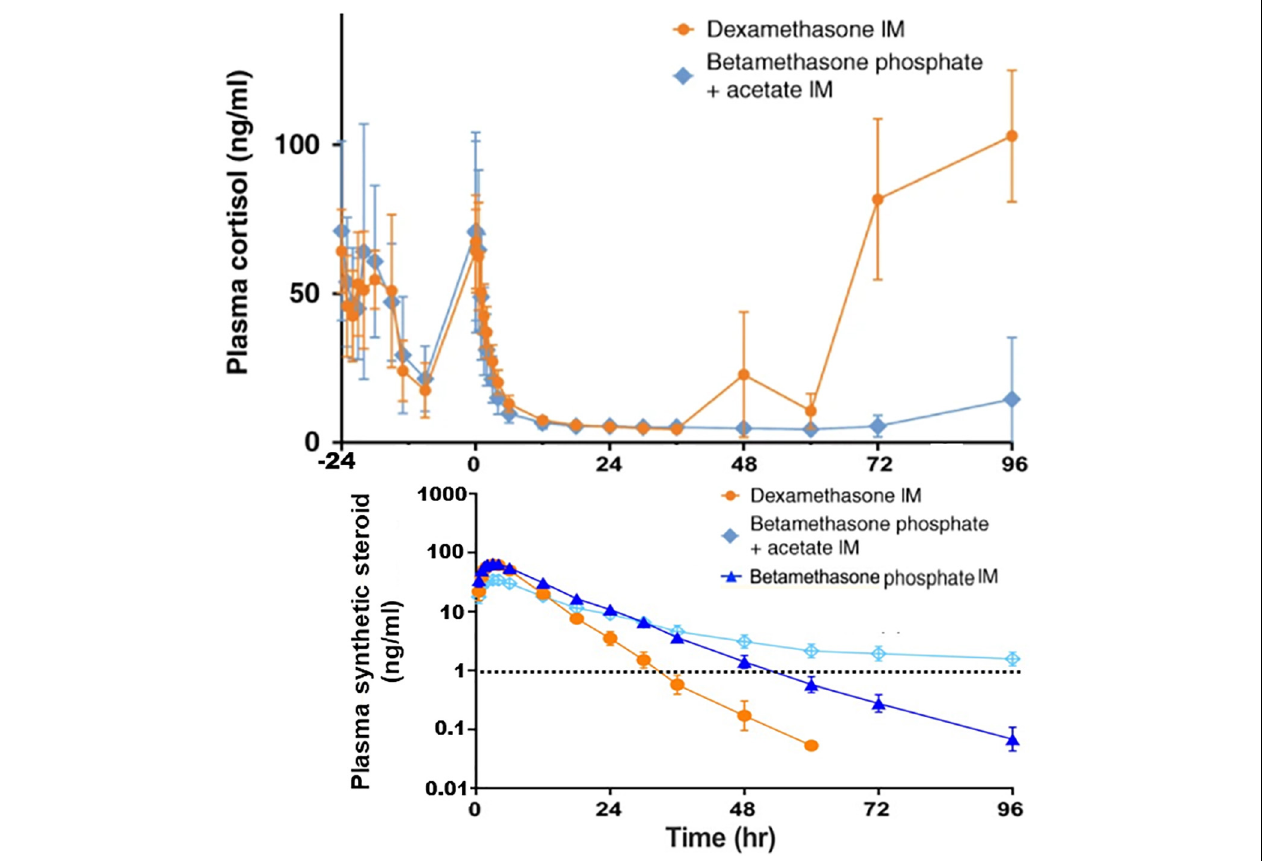
FIGURE 1 | Measurements of plasma concentrations of cortisol and the synthetic steroids in non-pregnant female subjects. Cortisol concentrations are shown starting 24 h before the intramuscular (IM) injections of the following synthetic glucocorticoids: Dexamethasone phosphate (6 mg), Betamethasone acetate (3 mg) + Betamethasone phosphate (3 mg), or Betamethasone phosphate (6 mg). Betamethasone was only half of the single antenatal betamethasone dose. The limit of the synthetic steroid ( ∼ 1 ng/ml) known to suppress the endogenous cortisol synthesis is shown by dashed line. As a result of the slow release of intramuscular betamethasone acetate, its concentration in plasma exceeds 1 mg/ml even 4 days after the injection. This is likely to take place in pregnant mothers and since the synthetic steroid passes to the fetal blood, suppression of cortisol synthesis of the fetus and the newborn infant shortly after the birth is anticipated. The data shown is from the study by Jobe et al. (59, 141). Copyright from Springer Nature, and from Wiley Periodicals,